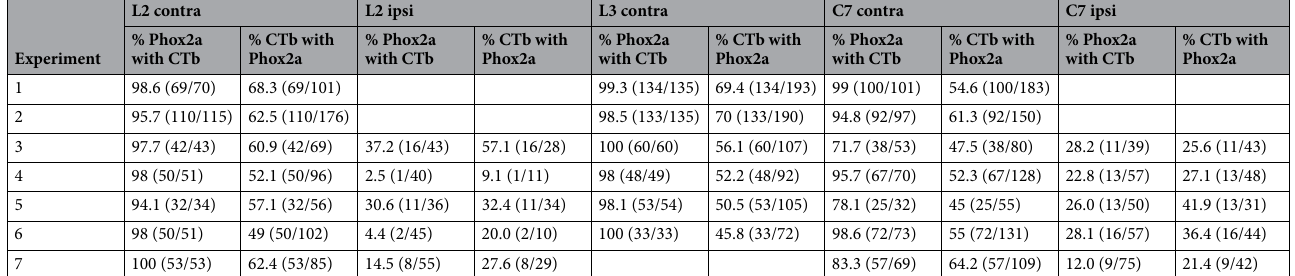
Table 2. Quantitative data for retrograde tracing experiments involving injection of cholera toxin B (CTb) into the lateral parabrachial area. Cells show percentages, with the actual numbers in parentheses. Note that in experiments 1 and 2 CTb was injected bilaterally into the LPb. Data from both sides were pooled for the L2 and C7 segments and this is entered under “contra” in both cases.